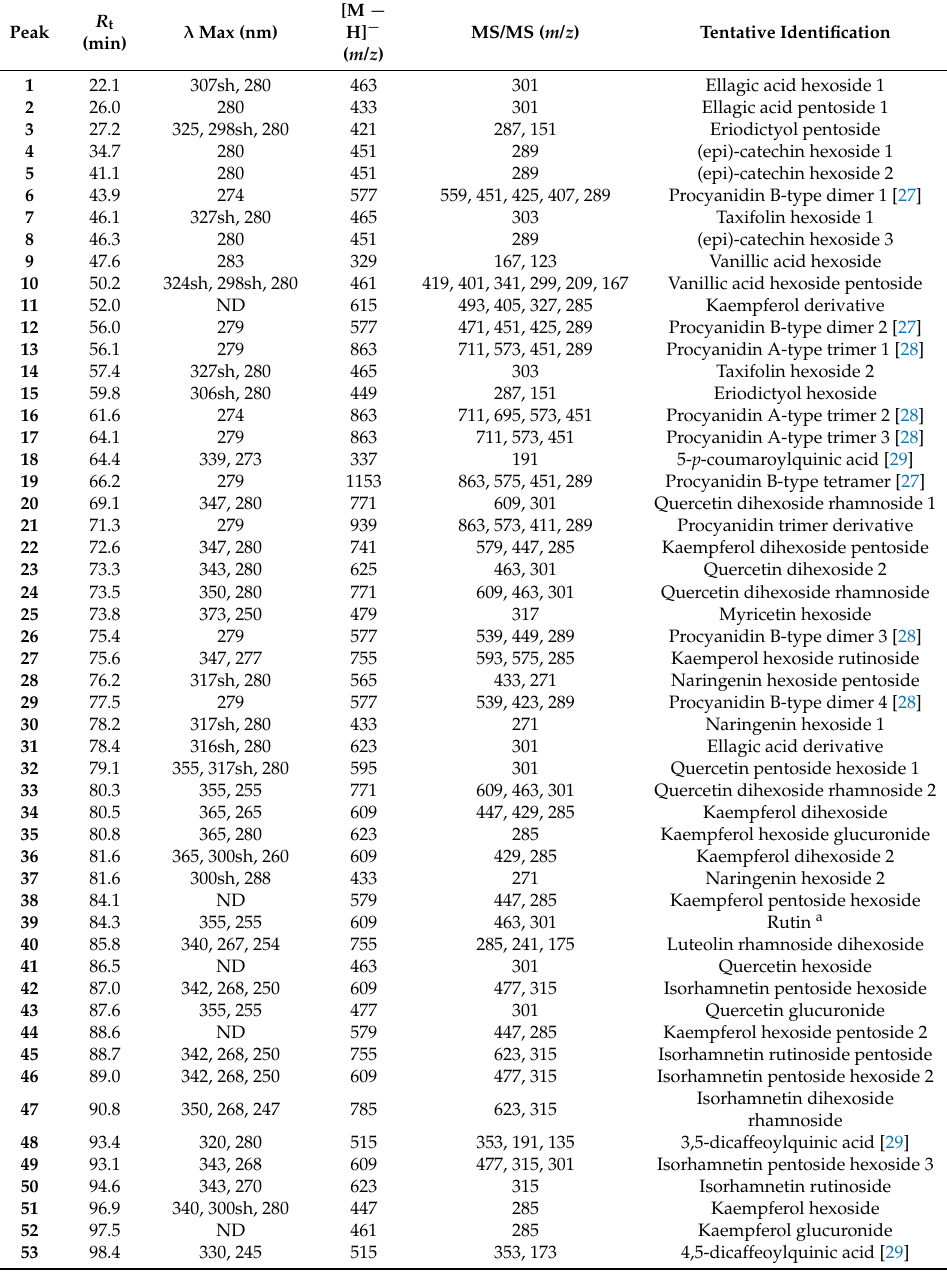
Table 3. Tentative identification of compounds in the phenolic-enriched extract of G. decorticans fruits by